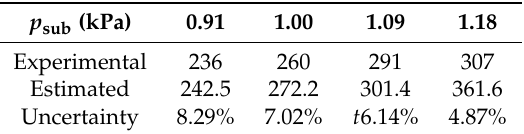
Table 6. Experimental and estimated mean volumetric flow rates along with a measure of uncertainty in the form of a standard deviation as a percentage of the estimated value. Data are all in